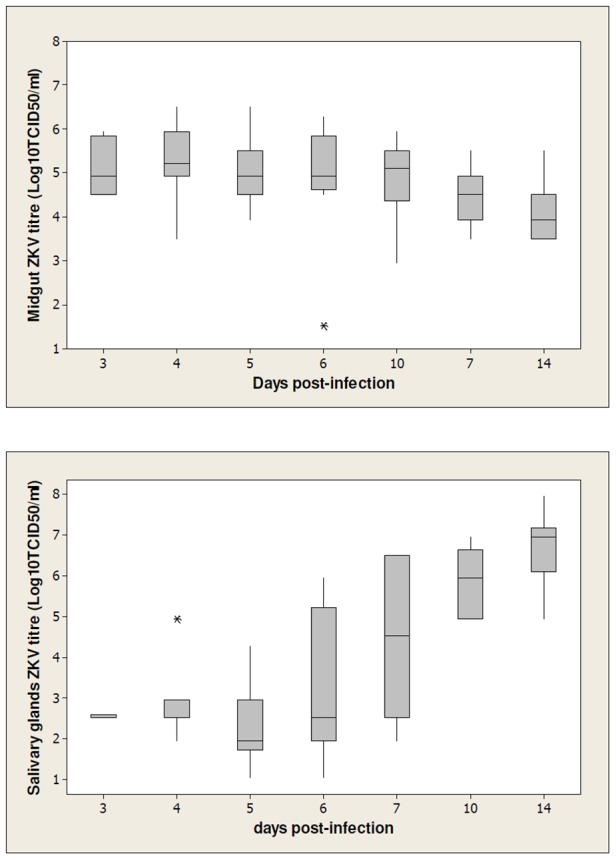
Box plots of ZIKV midgut and salivary glands titres at different days post-infection.Each box represents the median (horizontal bar), the interquartile range (box) and the full range (“whiskers”). Outliers are denoted by asterisk (*).